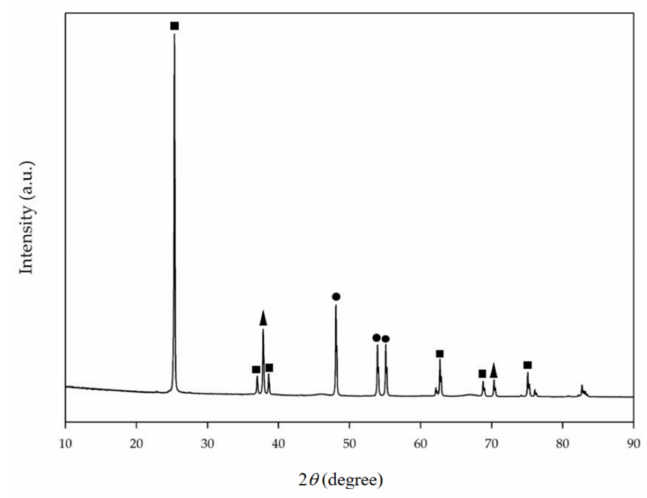
Figure 5. The di ff raction peaks of the Pd / Al 2 O 3 catalyst analyzed by an X-ray di ff ractometer ( (cid:8) PdO, (cid:78) Al (cid:4) TiO 2 O 3 , and 2 ). Table 2. Kerosene selectivity results for every run order designed by box-Behnken design (BBD). Standard